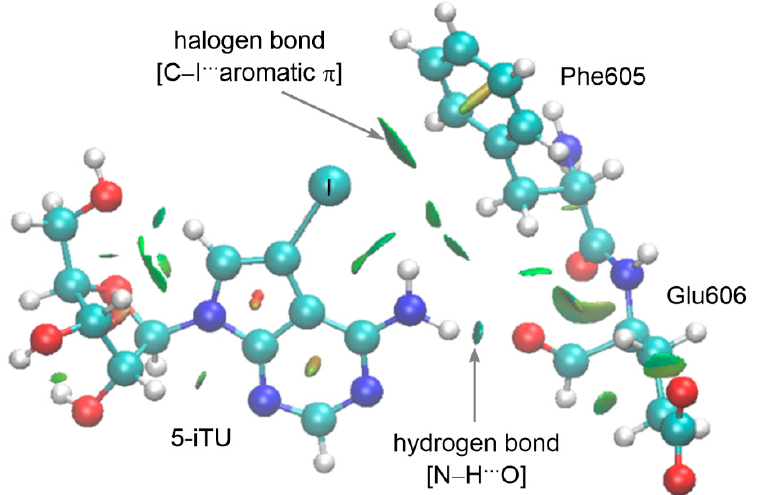
Figure 7. NCI isosurface between the tubercidin ligand 5-iTU and Haspin key residues (Phe605- Glu606) of PDB 6G34. Interaction strength increases from green to blue.